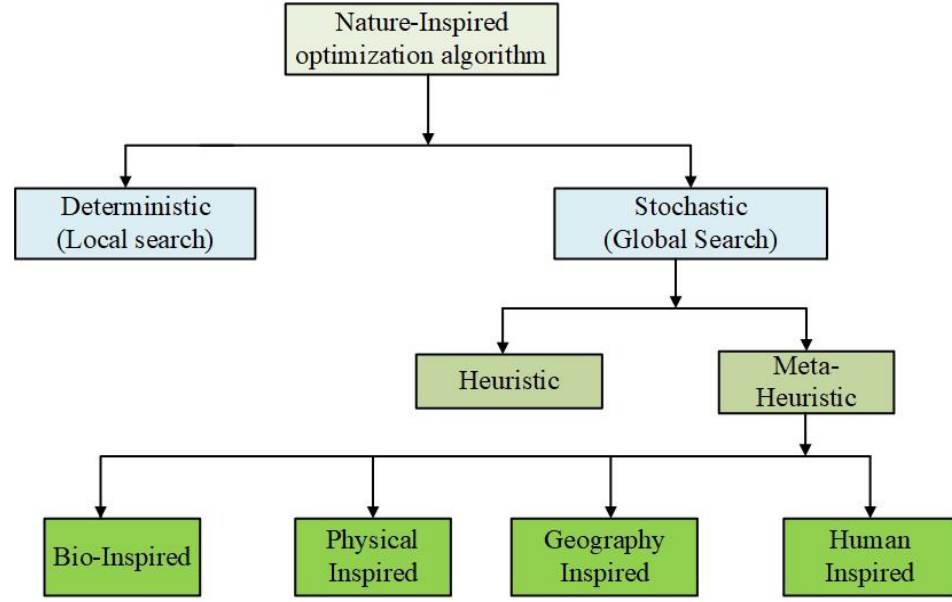
Figure 1. Classification of Nature-inspired Optimization Algorithm.